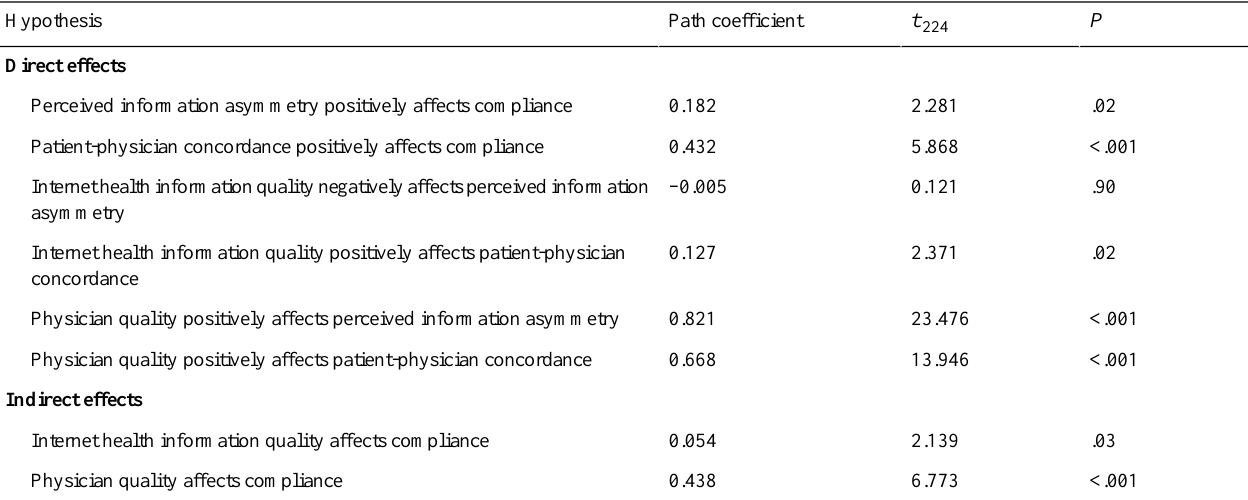
Table 3. Partial least squares path analysis for direct and indirect